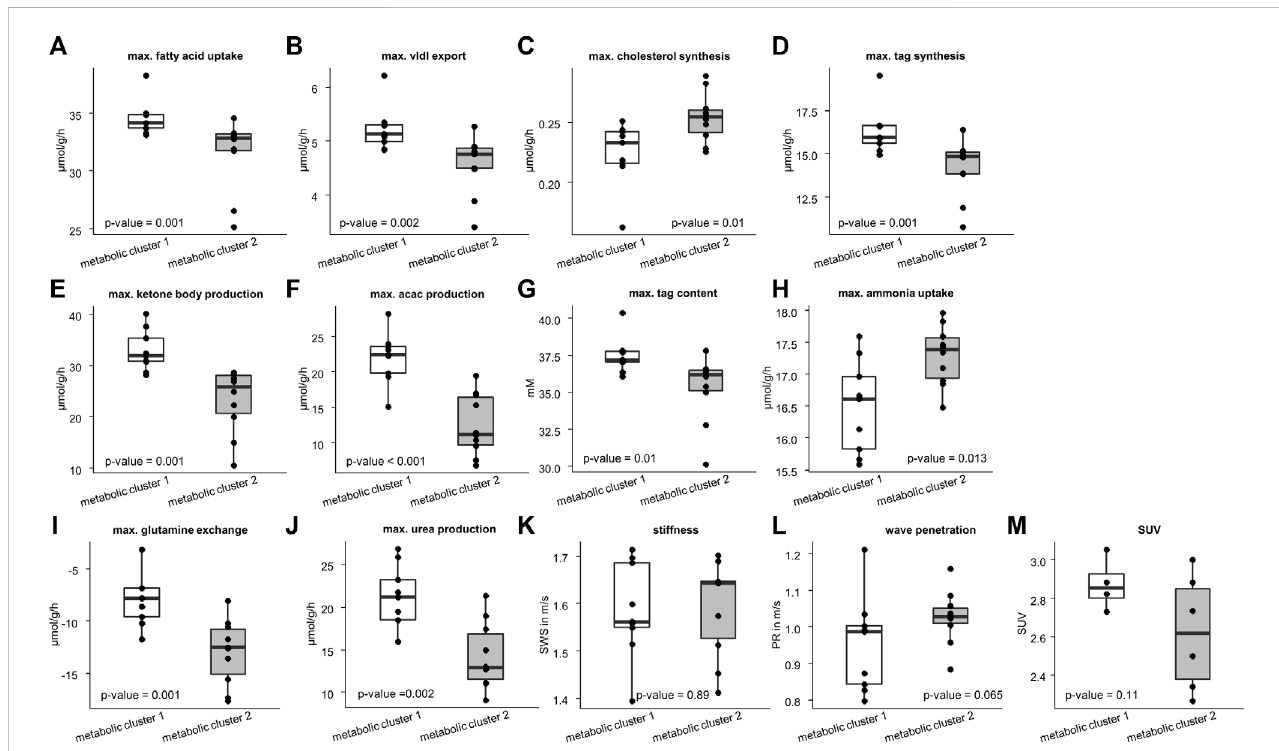
FIGURE 4 Differences in metabolic capability and imaging parameters between the two metabolic clusters. Cluster 1 consists of 10 samples and cluster 2 of 9 samples. Metabolic characteristics: (A) fatty acid uptake; (B) very low density lipoprotein (vldl) export; (C) cholesterol synthesis; (D) triacylglycerol (tag) synthesis; (E) ketone body production; (F) acetylacetone (acac) production; (G) max tag content; (H) ammonia uptake; (I) glutamine exchange; (J) max urea production. Imaging parameters: (K) shear wave speed (SWS); (L) wave penetration (PR); (M) standardized uptake value (SUV). Corresponding p -values based on two-sided t -test or Wilcoxon signed-rank test are given. The center line represents the median, the box represents the interquartile range, and the whiskers are de fi ned by values within 1.5 times the interquartile range. Outliers are represented as dots.